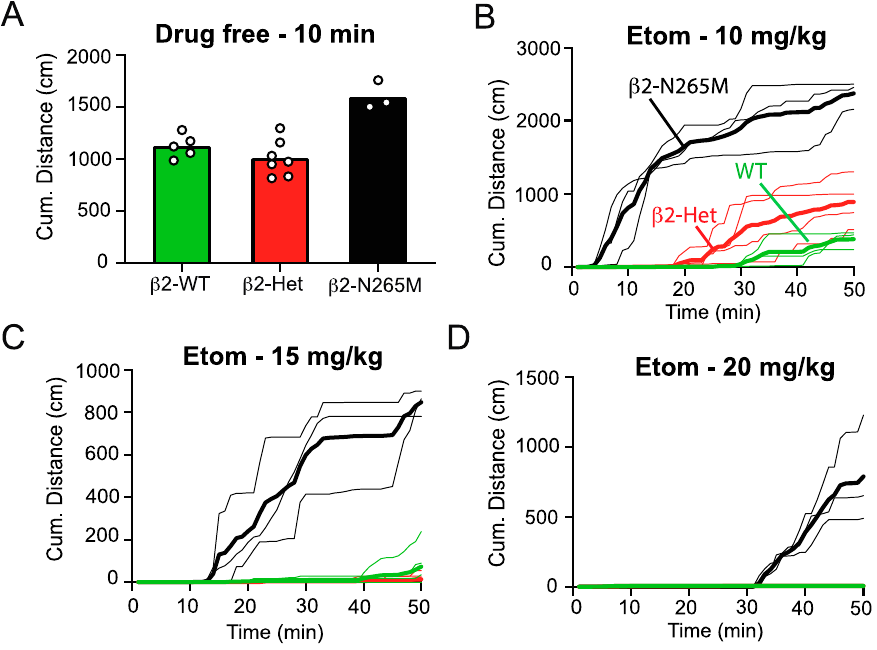
Figure 3. Recovery of β 2-N265M mice from different doses of etomidate. ( A ) Under drug-free conditions, β 2-N265M mice had a higher average cumulative distance traveled over 10 min compared to both the β 2-WT and the β 2-Het mice (1601 ± 136.5 vs. 1122 ± 111.7 vs. 1007 ± 172.7, respectively, p < 0.001, one-way ANOVA). ( B ) Following etomidate 10 mg/kg i.p., both β 2-Het and β -WT mice were sedated for an average of 20 and 30 min, respectively (n = 4 and 3, respectively). β 2-N265M mice resisted the sedative effect of etomidate at this dose and were sedated for an average of only 5 min (n = 3). ( C ) Following etomidate 15 mg/kg i.p., both β 2-Het and β -WT mice were sedated for an average of 40 min (n = 6 and 5, respectively). β 2-N265M mice resisted the sedative effect of etomidate at this dose and were sedated for an average of only 12 min (n = 3). ( D ) Following etomidate 20 mg/kg i.p., neither the β 2-Het nor the β -WT mice recovered from sedation within the 50 min exper- iment (n = 5 and 7, respectively). β 2-N265M mice were sedated for an average of 31 min at this dose (n = 3).